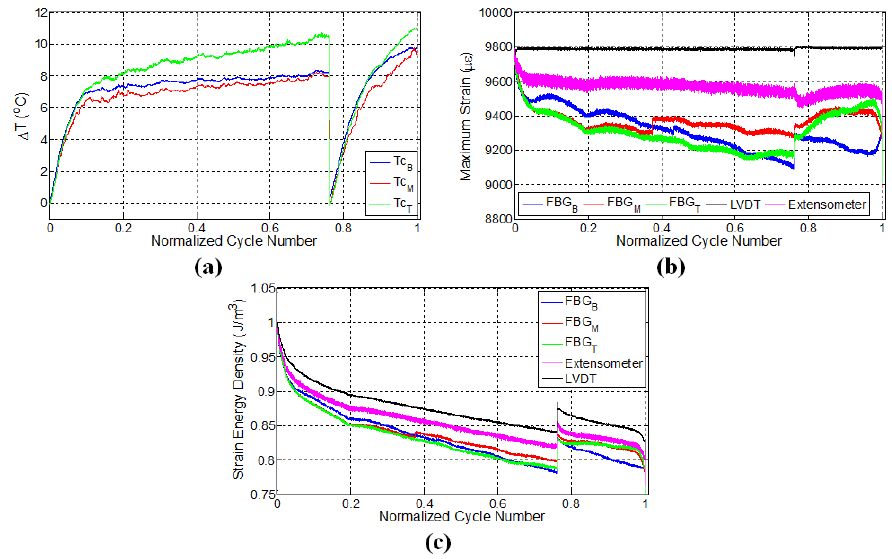
Figure 5. Evolution of ( a ) temperature; ( b ) strain and ( c ) strain energy density for specimen